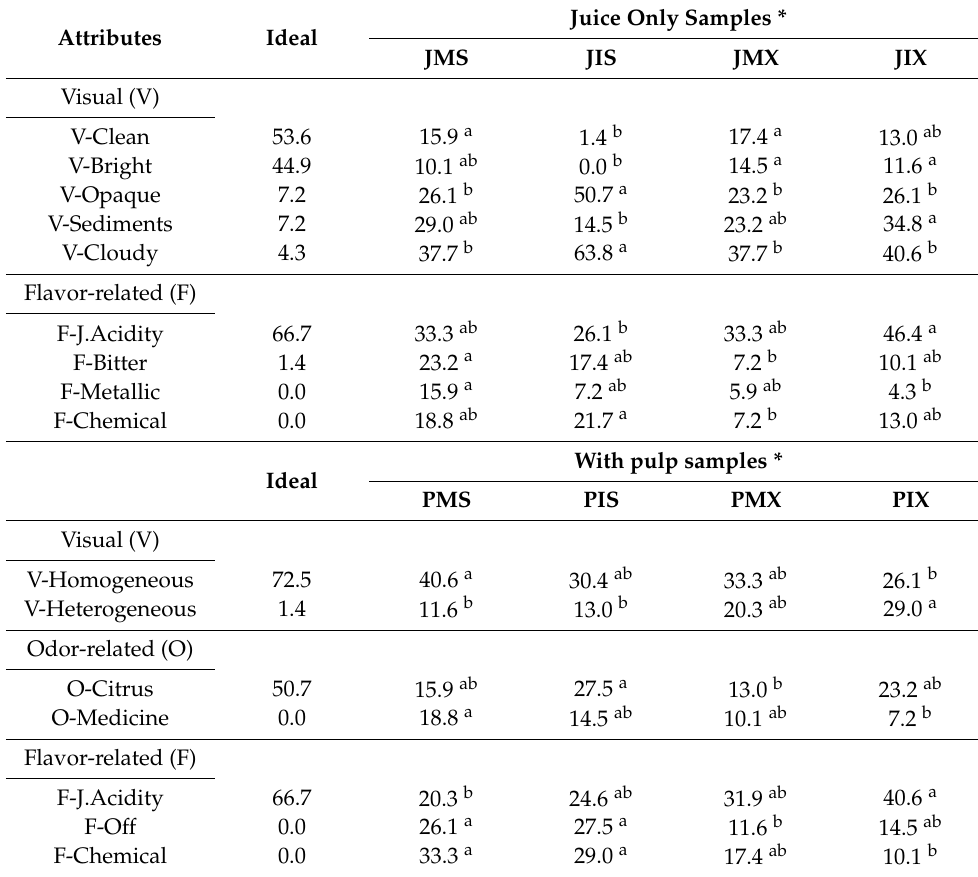
Table 4. Frequency of selection (%) for attributes for which a statistically significant difference ( p < 0.05) among samples was found by using Cochran’s Q test for each type of sample (with juice only or with